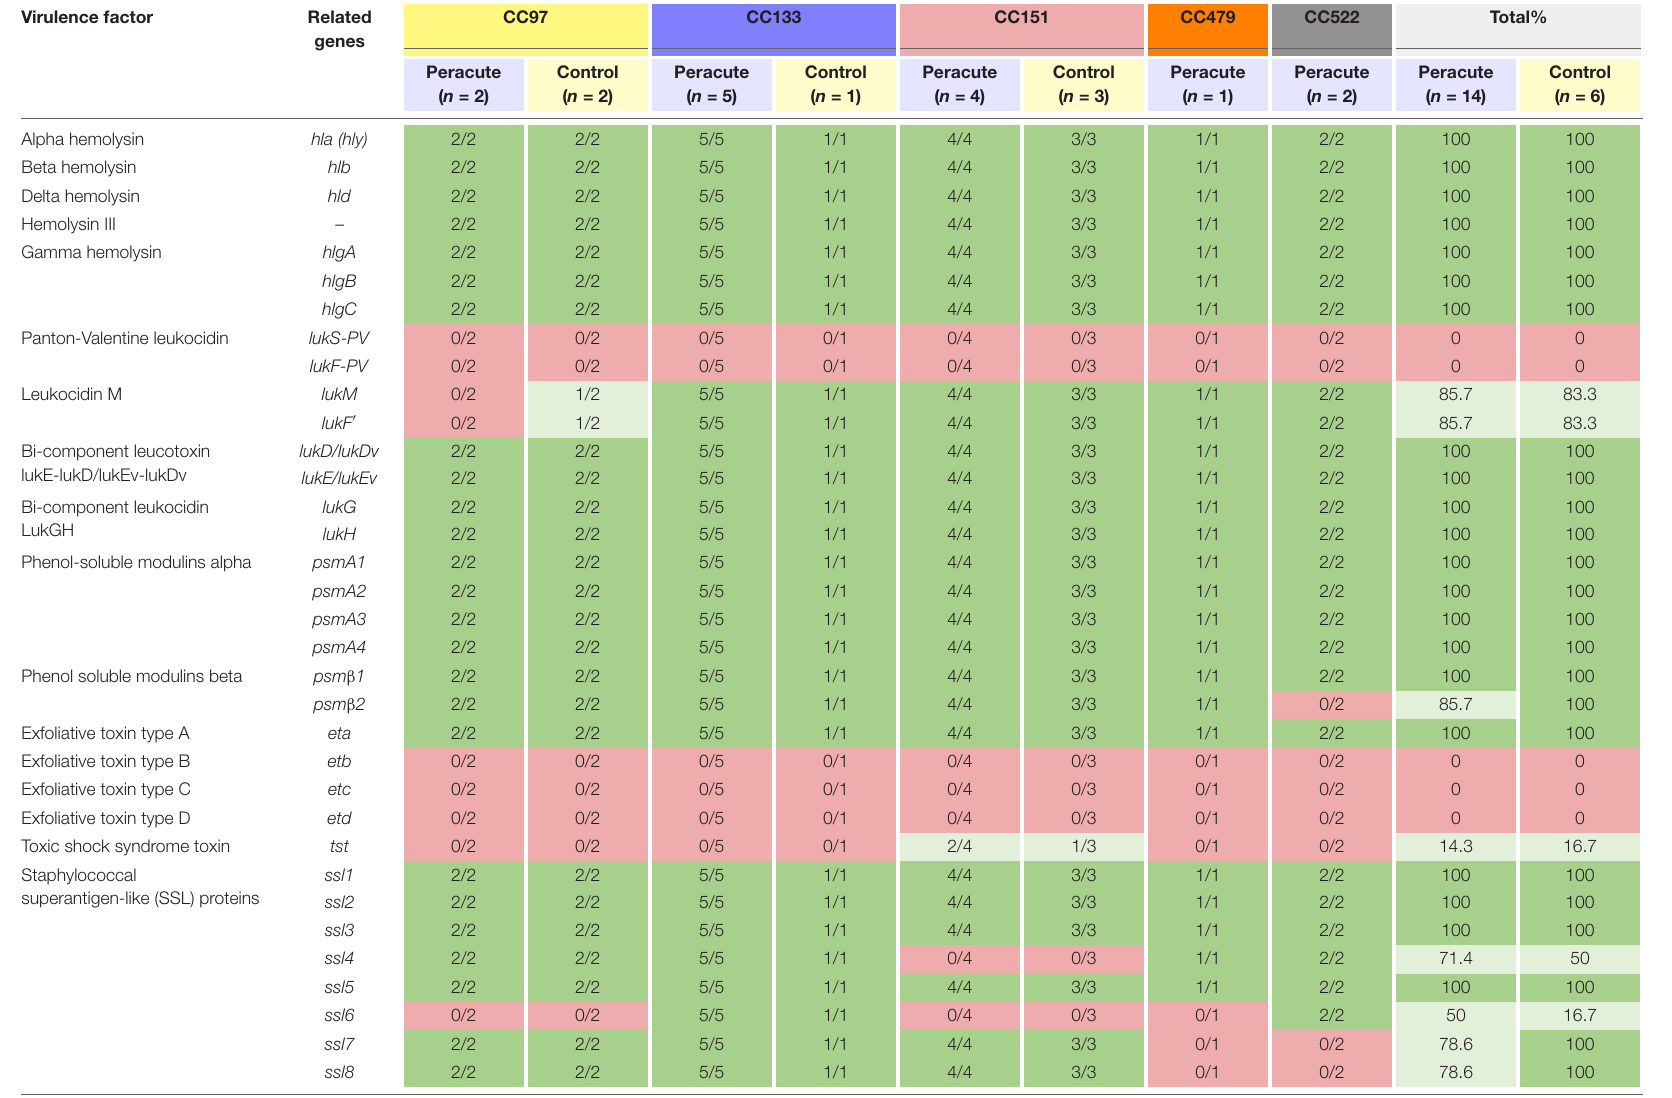
TABLE 3 | Distribution of toxin genes in 20 Staphylococcus aureus isolates from bovine mastitis milk samples classified by clonal complex (CC) and study